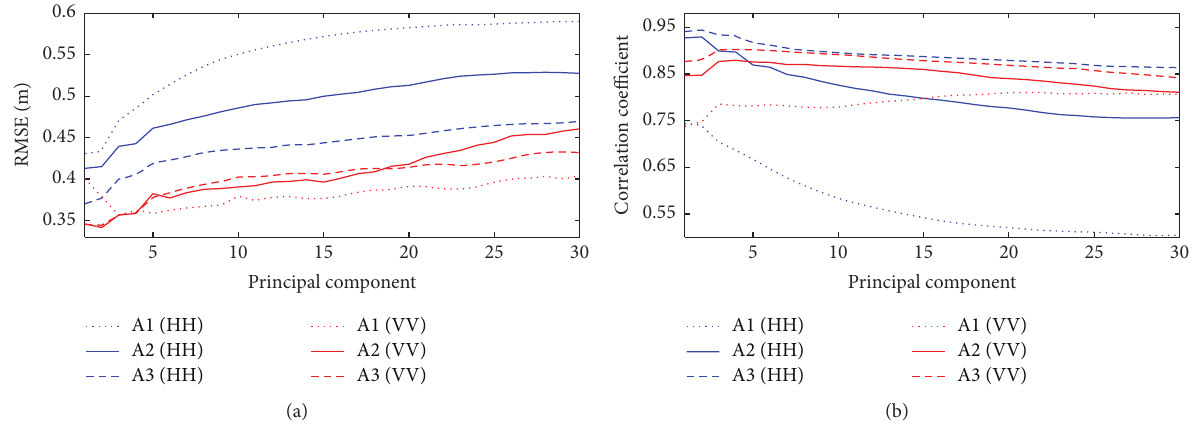
Figure 5: (a) The RMSE between the SWH measured by the buoy and those retrieved from different principal components of X-band marine radars, and (b) the correlation coefficients between the wind speed and the SWH retrieved from different principal components of X-band marine radars in Regions A1–A3.